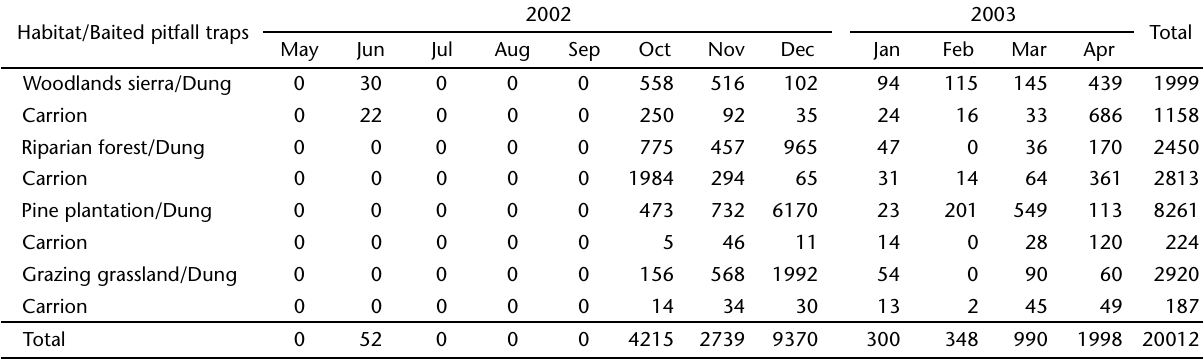
Table I. Abundance of Diptera collected in four habitats at the Sierra de Minas, Department of Lavalleja, Uruguay, from May 2002 to April 2003. Habitat/Baited pitfall traps